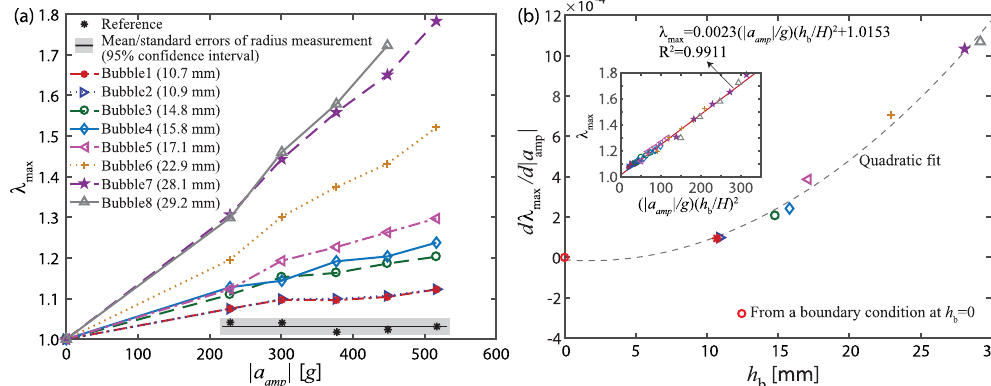
Figure 2. The correlation between the amplitude of input acceleration (| a amp |) and the corresponding normalized maximum radius ( λ max = r max / r 0 ) of bubbles at different depth of bubbles ( h b ) where r max and r 0 are the maximum and initial radii, respectively. The λ max and | a amp | relation in ( a ) indicates that λ max is linearly proportional to | a amp | while each slope, d λ max / d | a amp |, depends on h b . In ( b ), the slopes for each λ max and | a amp | curve are shown as a function of h b . Note that pressure at h b = 0 is expected to be zero to satisfy a free surface boundary condition. The 2 relation using the least square fitting inset in b confirms the λ − ∝ a h 1 max amp b